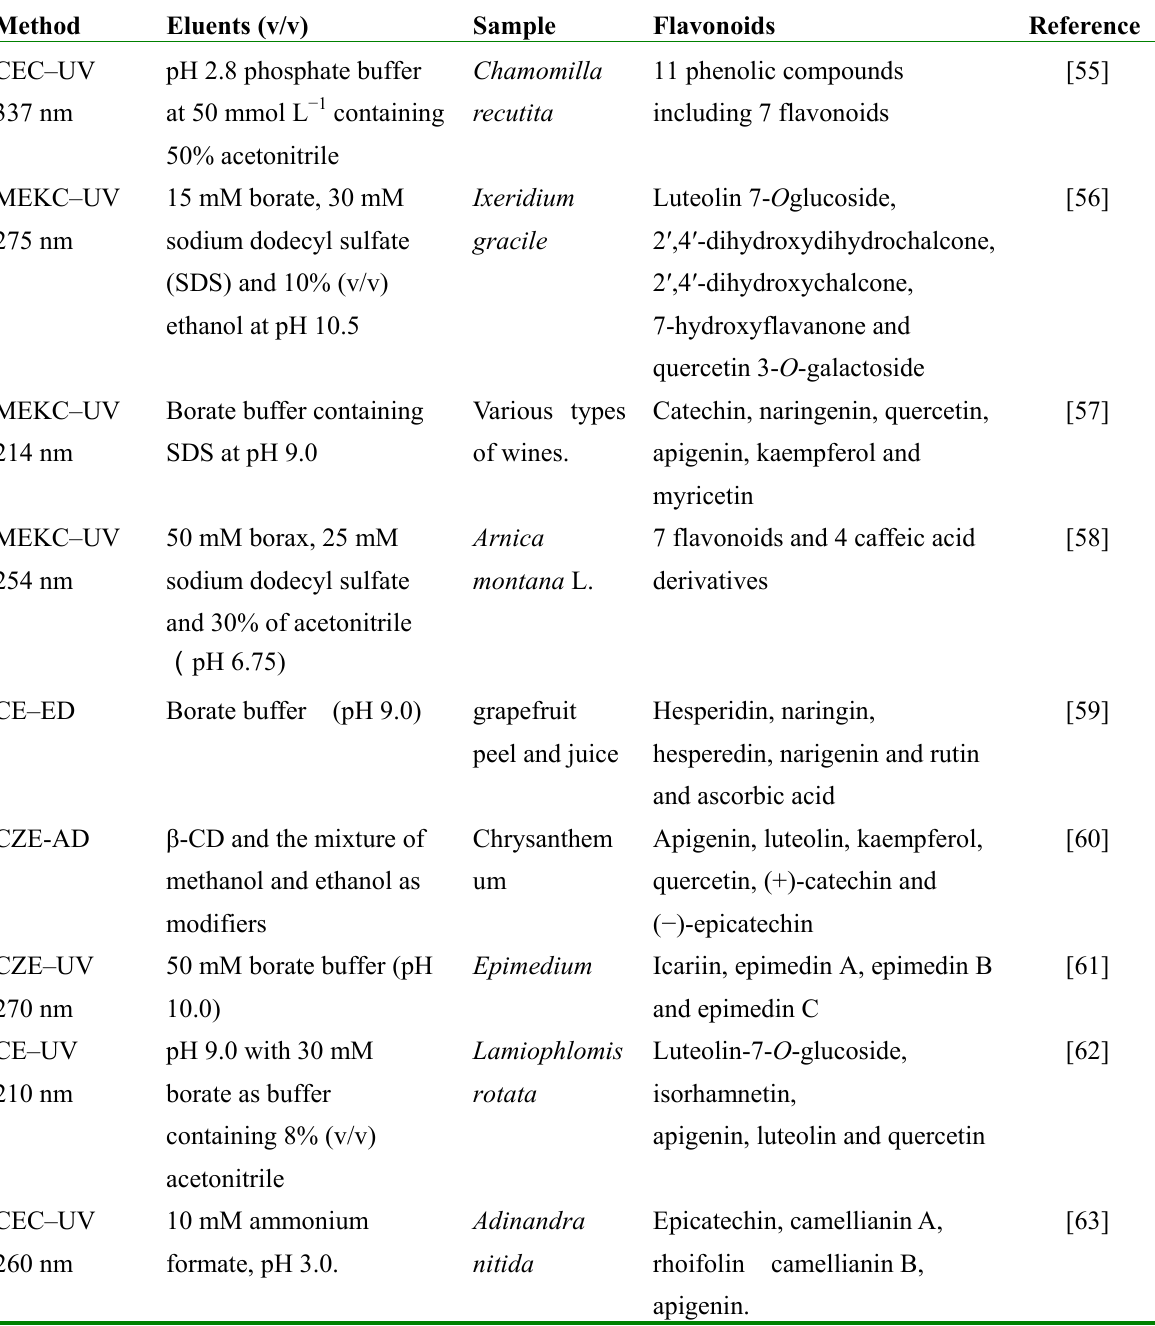
Table 4. Representative application of CE to the analysis of